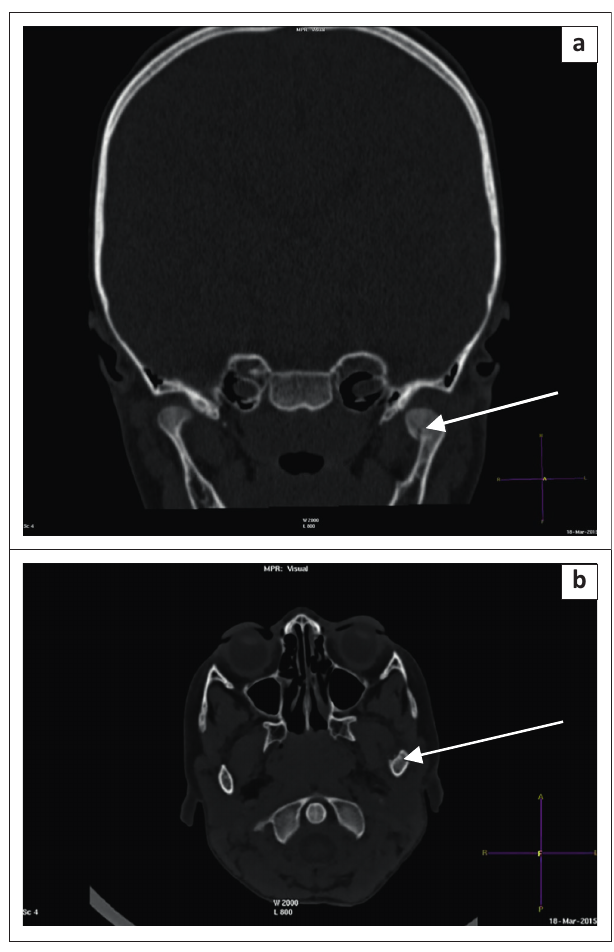
FIGURE 5: (a) A 6 year old female sustained a head injury of unknown mechanism and presented with vomiting. Coronal MPR view of the bony algorithm demonstrated a linear fracture of the left mandibular condyle (white arrow). The corresponding axial views are far more subtle; (b) Axial CT bony algorithm for the above patient, showing lucency of the left mandibular condyle (white